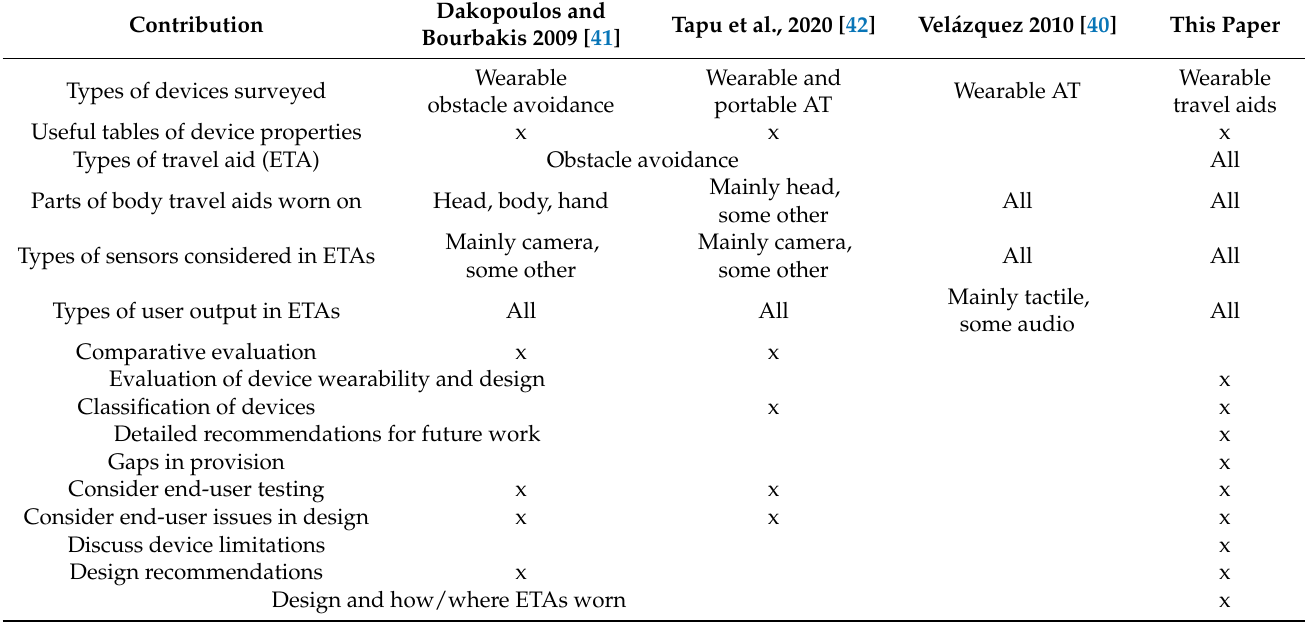
Table 1. Contributions and other features of the three other survey papers and this